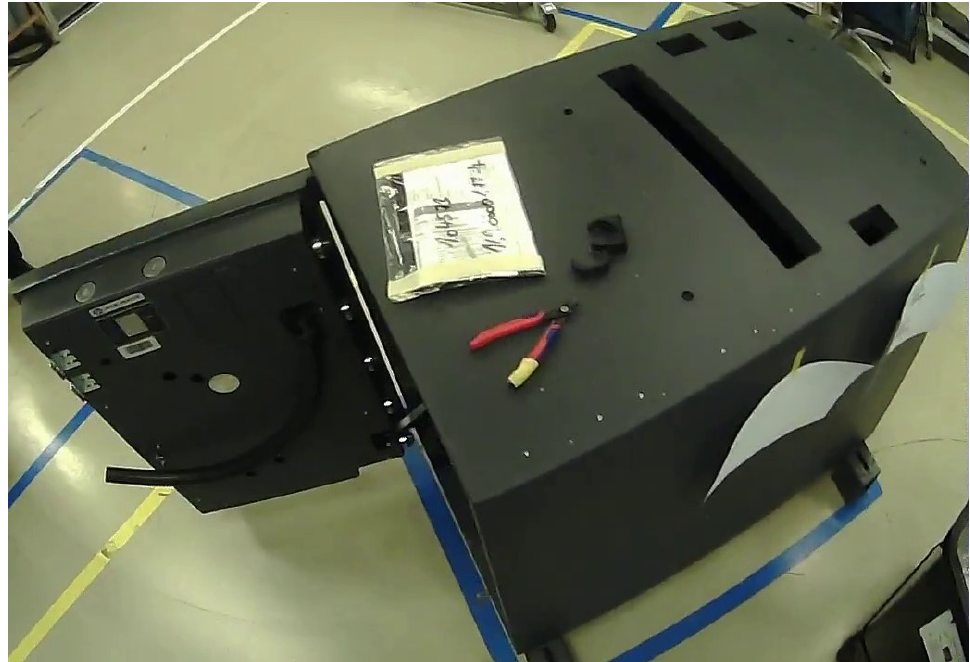
Figure 9. The main part of the ATM where workers perform most of the